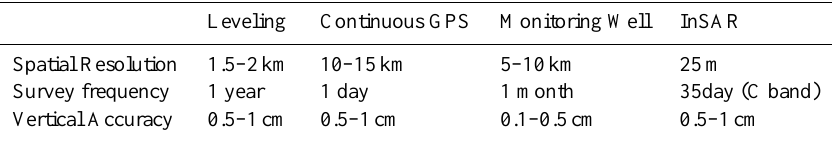
Table 2. Multi-sensor comparison